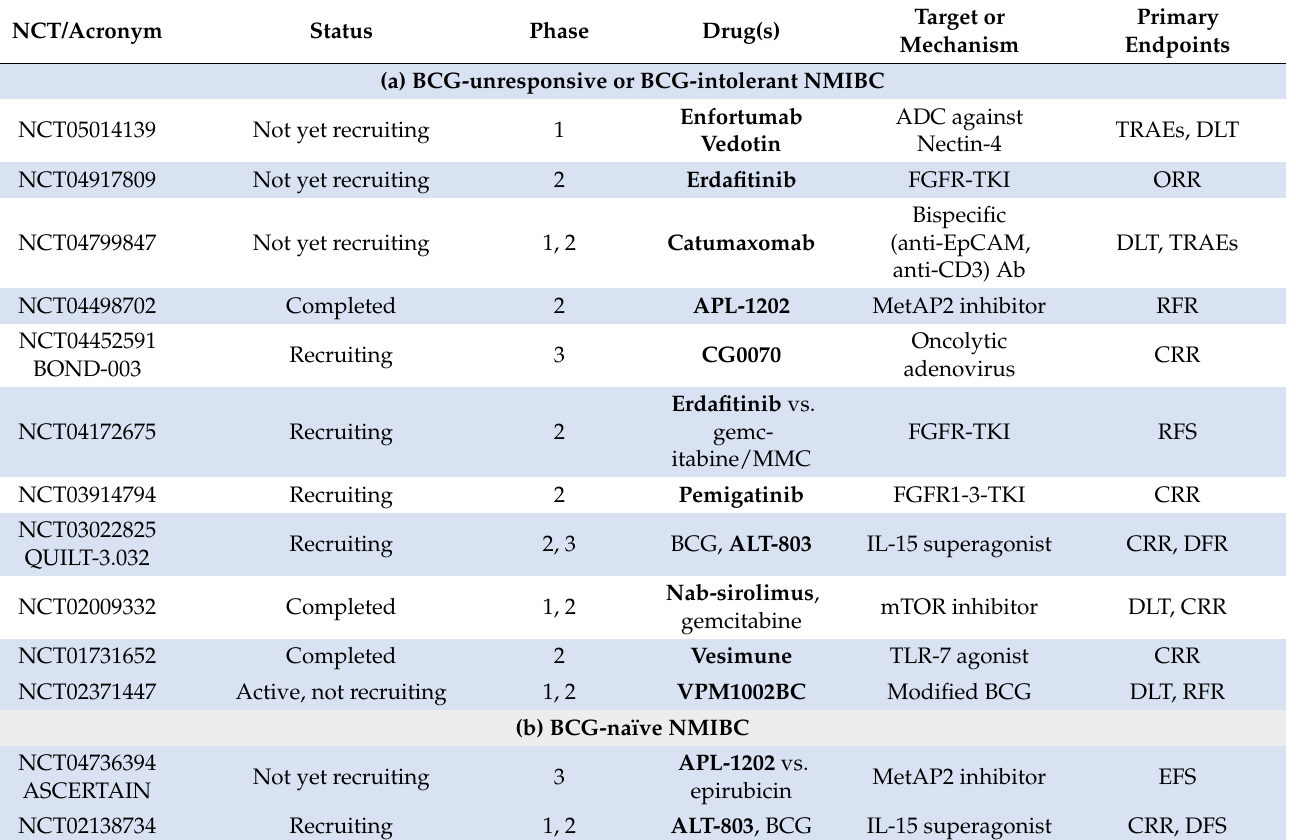
Table 3. Clinical trials testing novel or emerging drugs (in bold font) alone or in combination in